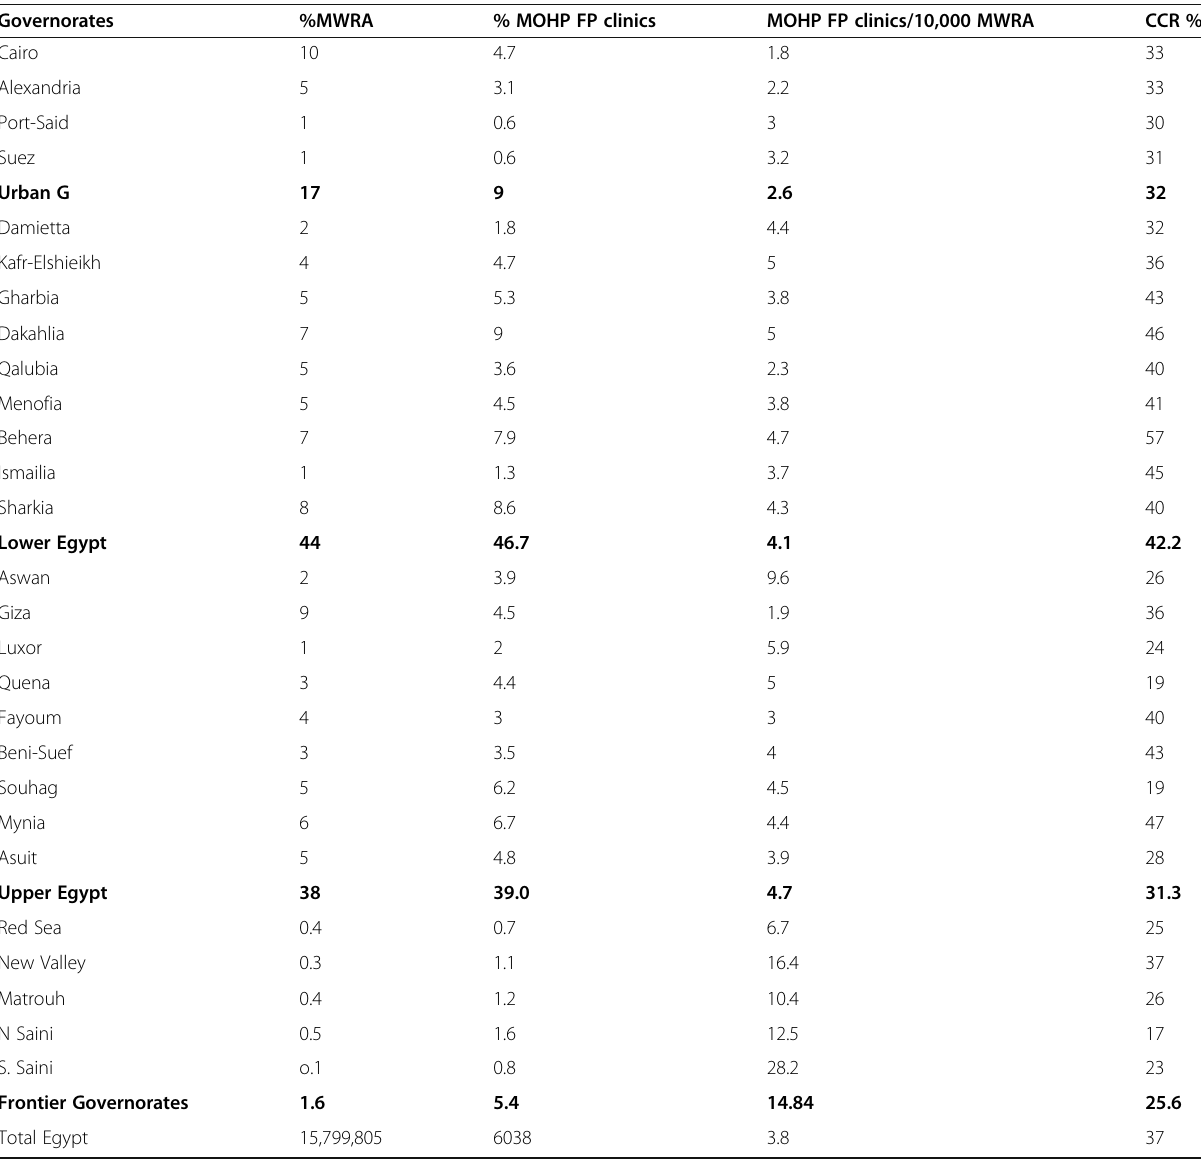
Table 2 Distribution of married women in the reproductive age, MOHP-FP clinics and contraceptive coverage rate across Egypt governorate 2014